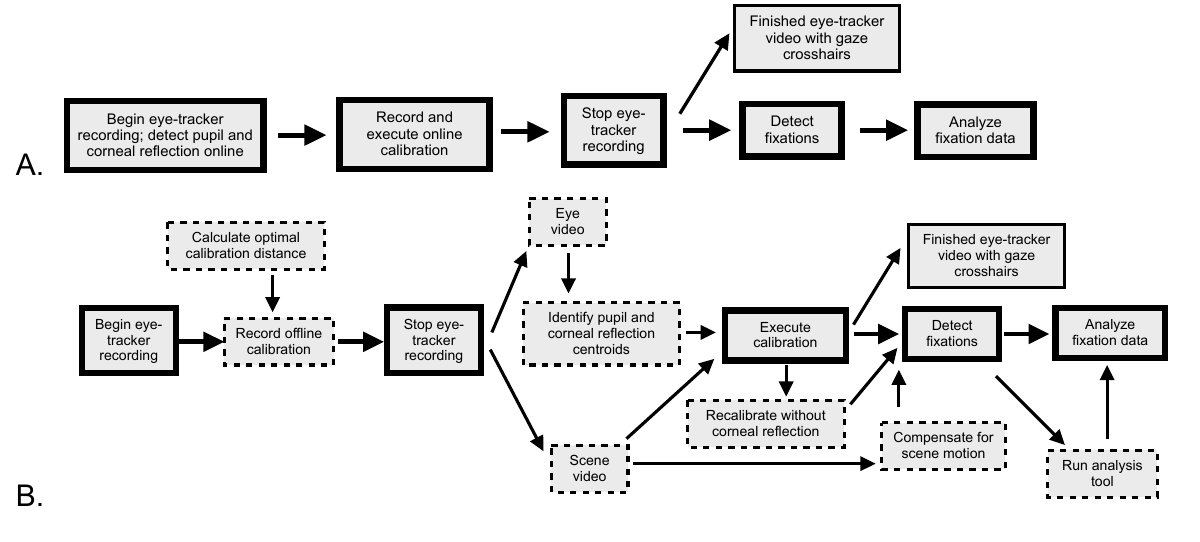
Figure 1. Flowchart of eye-tracking methods in different environments. 1A shows the method traditionally used in stationary eye- tracking, and 1B displays the stages of our method of outdoor mobile eye-tracking. Stages with dashed borders in 1B do not exist as separate stages (or at all) in stationary